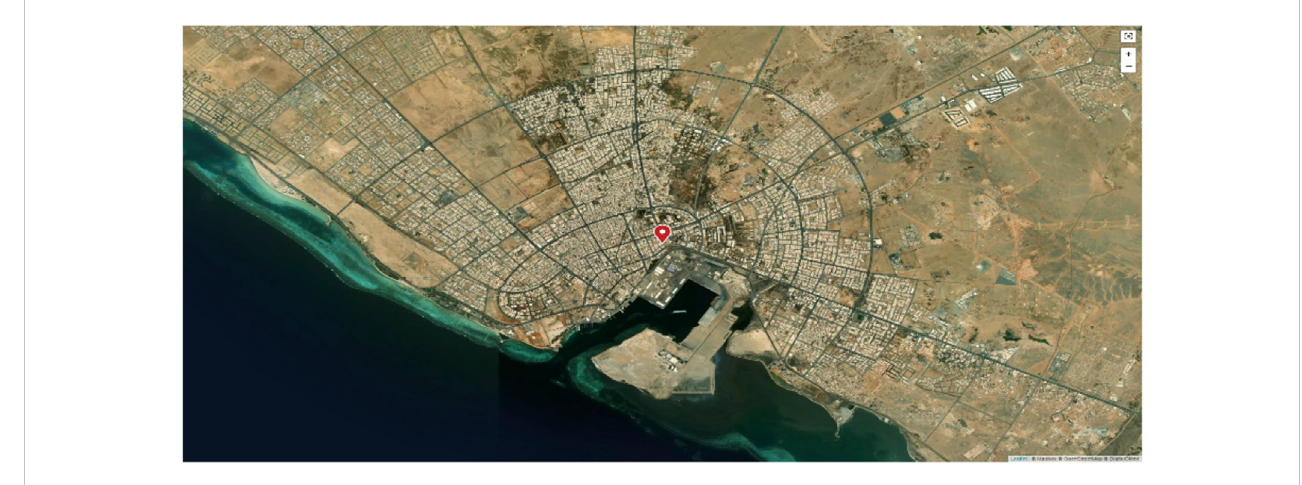
FIGURE 1 Map of Yanbu city.